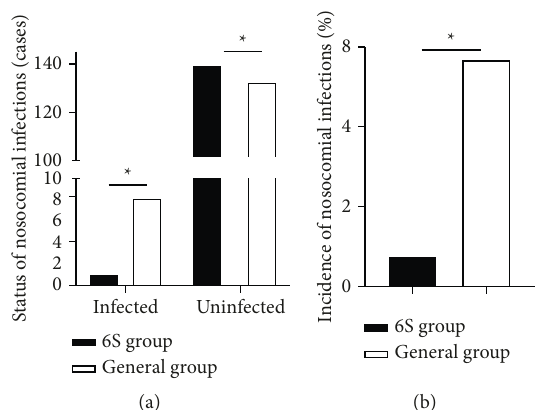
Figure 4: Analysis of nosocomial infections in two groups of patients. (a) The status of nosocomial infections (cases). (b) The incidence of nosocomial infections (%). The 6S group compared to the general group, ∗ P > 0 . 05.